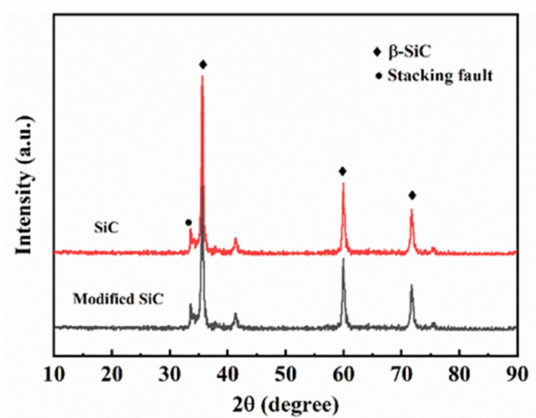
Figure 2. X-ray di ff raction (XRD) patterns of the silicon carbide (SiC) powder and PVP-modified SiC powder.